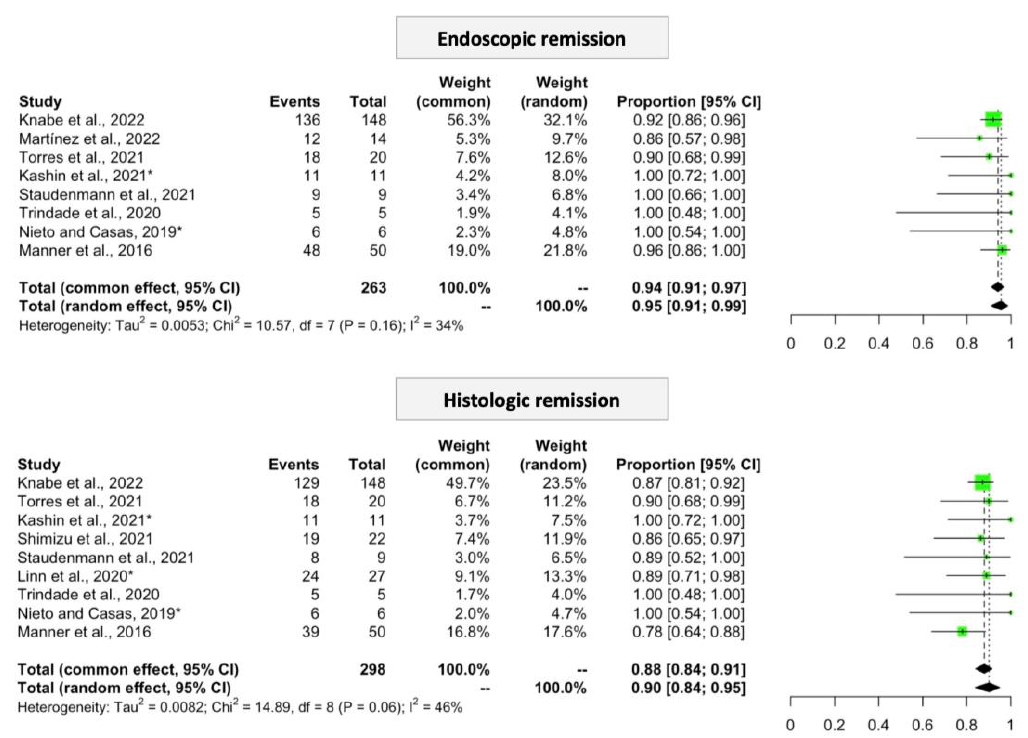
Figure 2. Proportions of achievement of endoscopic and histologic remission after hybrid argon plasma coagulation (hAPC) for Barrett’s esophagus (BE) ablation. Events = number of patients achieving endoscopic or histologic remission; total = number of patients evaluated in which study.